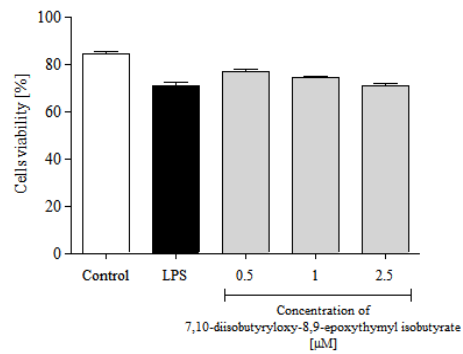
Figure 4. Cytotoxic effects of 7,10-diisobutyryloxy-8,9-epoxythymyl isobutyrate, at concentrations 0.5, µ M, on human LPS-stimulated neutrophils. Results shown as percentages of cells 1.0 and 2.5 μ M, on human LPS-stimulated neutrophils. Results shown as percentages of cells without 0.5, 1.0 and 2.5 LPS—cells stimulated with LPS (stimulated control). Statistical significance: * p < 0.05, with reference to a stimulated